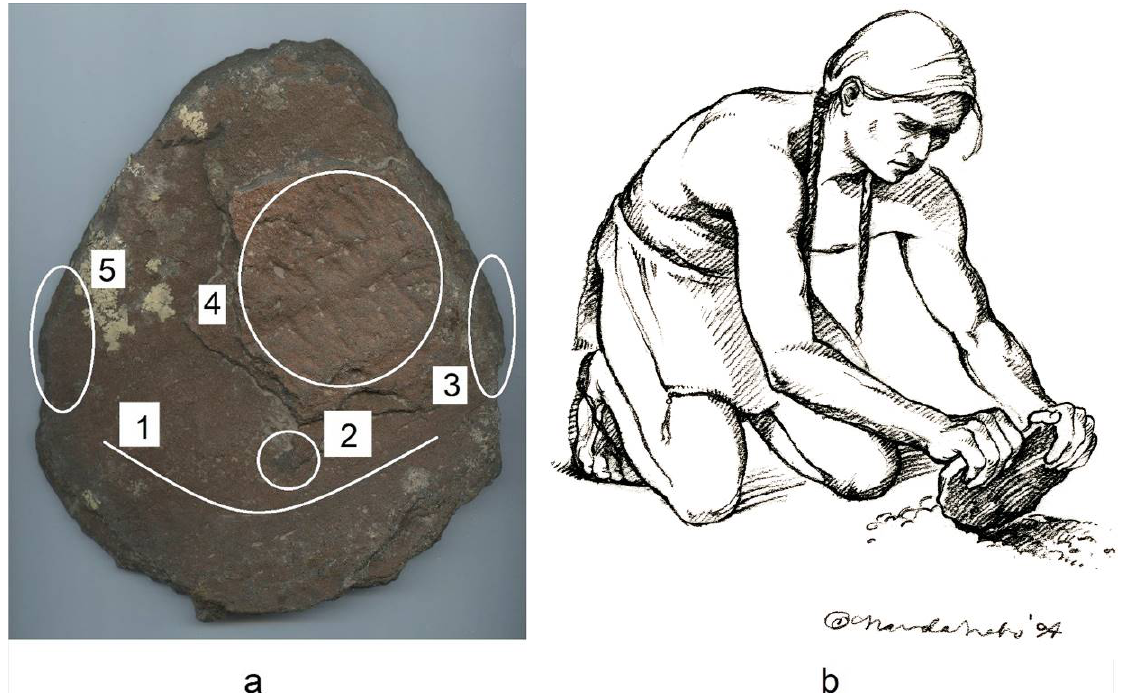
Figure 7. Specimen 6 (working edge on both ends), (a) Localized (2, 3, 5) and diffuse (1, 4) face polishing (see Figure 1). (b) Rendition of how disc, elliptical, ovate, and sub-rectangular-shaped tool forms were probably used. (Photograph by Steve Tomka; drawing by Narda